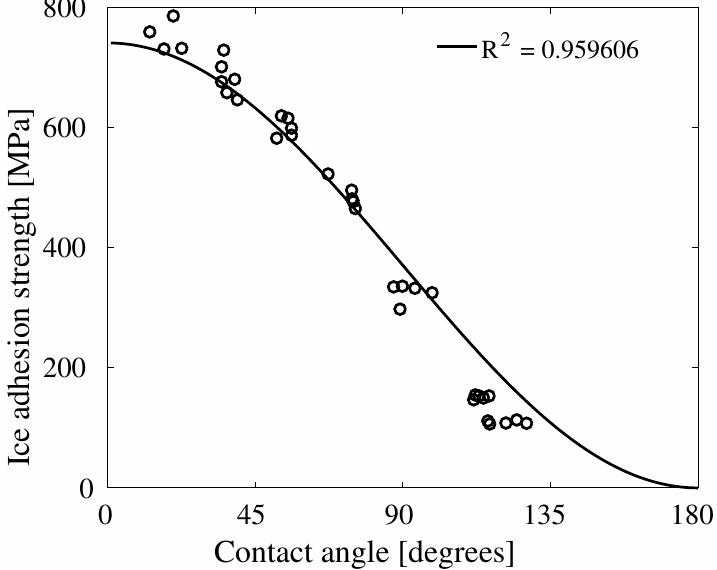
Figure 7. Ice adhesion strength as function of contact angle, with the relation from Equation (7) fitted to the data. It can be seen that the fit of the general relation shows a very high level of